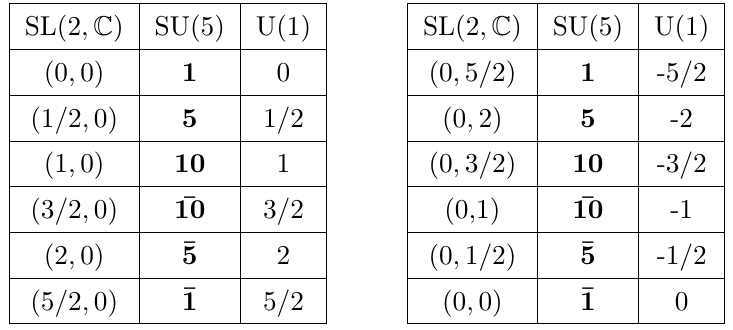
Table 4 . The irreducible chiral doubleton supermultiplets of SU(2 ; 2 j 5) and its conjugate, with the highest spin 5 = 2. The scalars here are singlets of SU(5). The vector (cid:12)eld strengths and their duals transform in 10 and (cid:22)10 of SU(5).